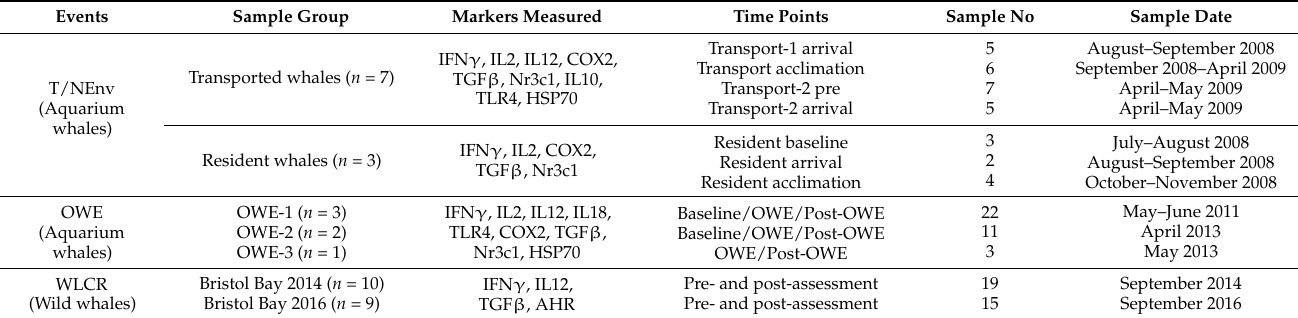
Table 1. Blood samples utilized for the current study for three separate events, transport and novel environment (T/NEnv), out-of-water examination (OWE) and wild beluga live capture–release health assessments (WLCR). Numbers of individual whales ( n ), markers measured, time points for each event, total number of blood samples collected, and sample dates are